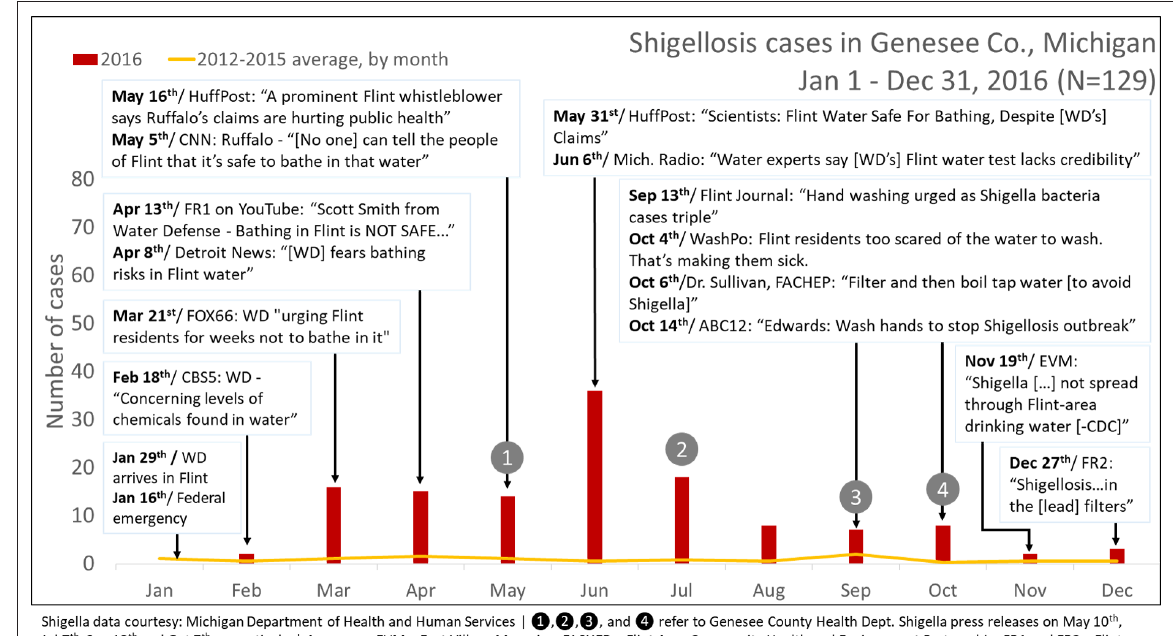
Figure 1: Shigellosis cases in Flint (2012–15 versus 2016) vis-à-vis conflicting public statements by Water Defense and others on bathing, showering, and Shigella in local, national, or social media. Monthly Shigella case data provided by Michigan Department of Health and Human Services (MDHHS). References (chronological as per graph): Wakefield 2016; Water Defense 2016b; WNEM 2016; Parkinson 2016; Lynch and Carah 2016; Mays 2016a; CNN 2016; Delaney 2016b; Delaney 2016a; Williams 2016; Acosta 2016; Andrews 2016; Sullivan 2016; ABC12 2016; Worth-Nelson 2016; TYT